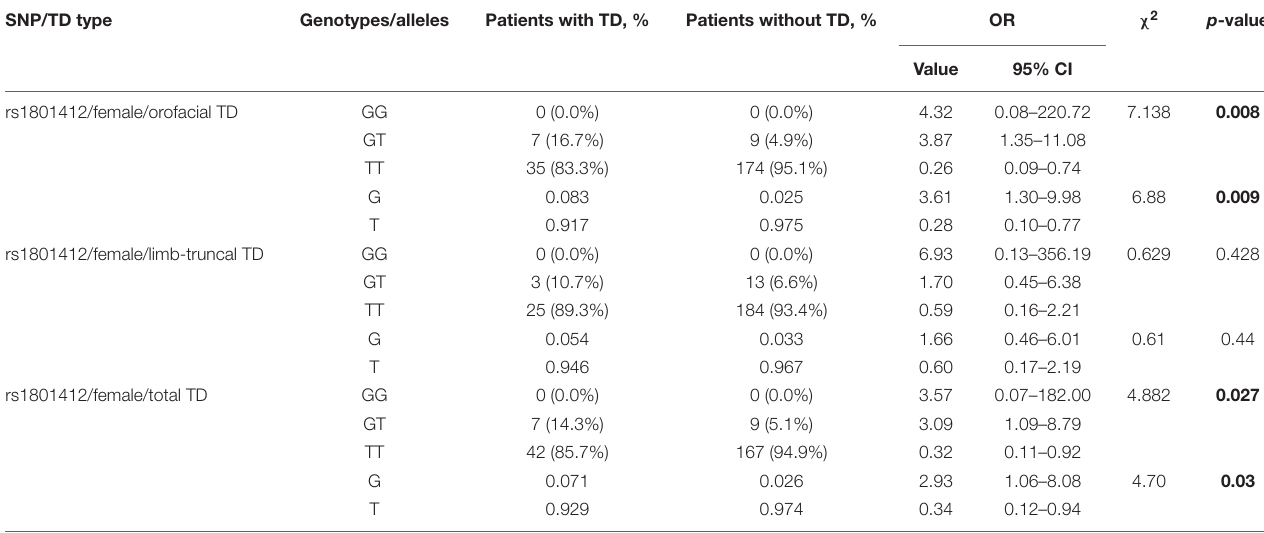
Significancy (p < 0.05) indicated in bold. TABLE 3 | Results of association analysis for genotypes and alleles of rs1801412 between groups of patients with different types of tardive dyskinesia and without tardive dyskinesia after dividing by sex. SNP/TD